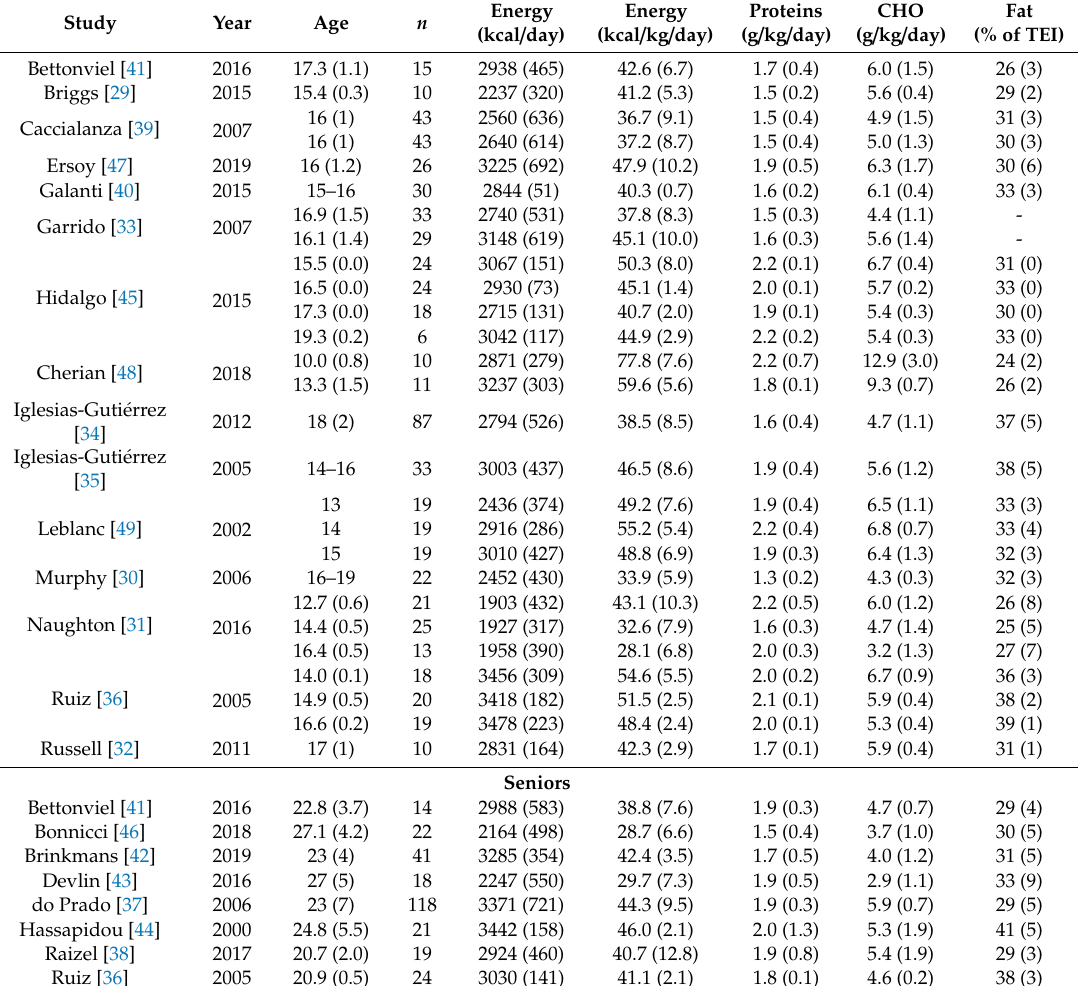
Table 3. Macronutrient intake in separate